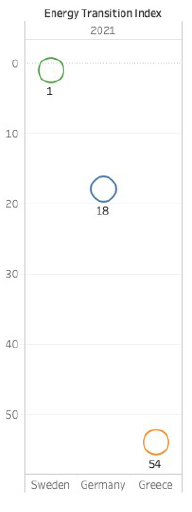
Figure 3. Energy Transition Index 2021.